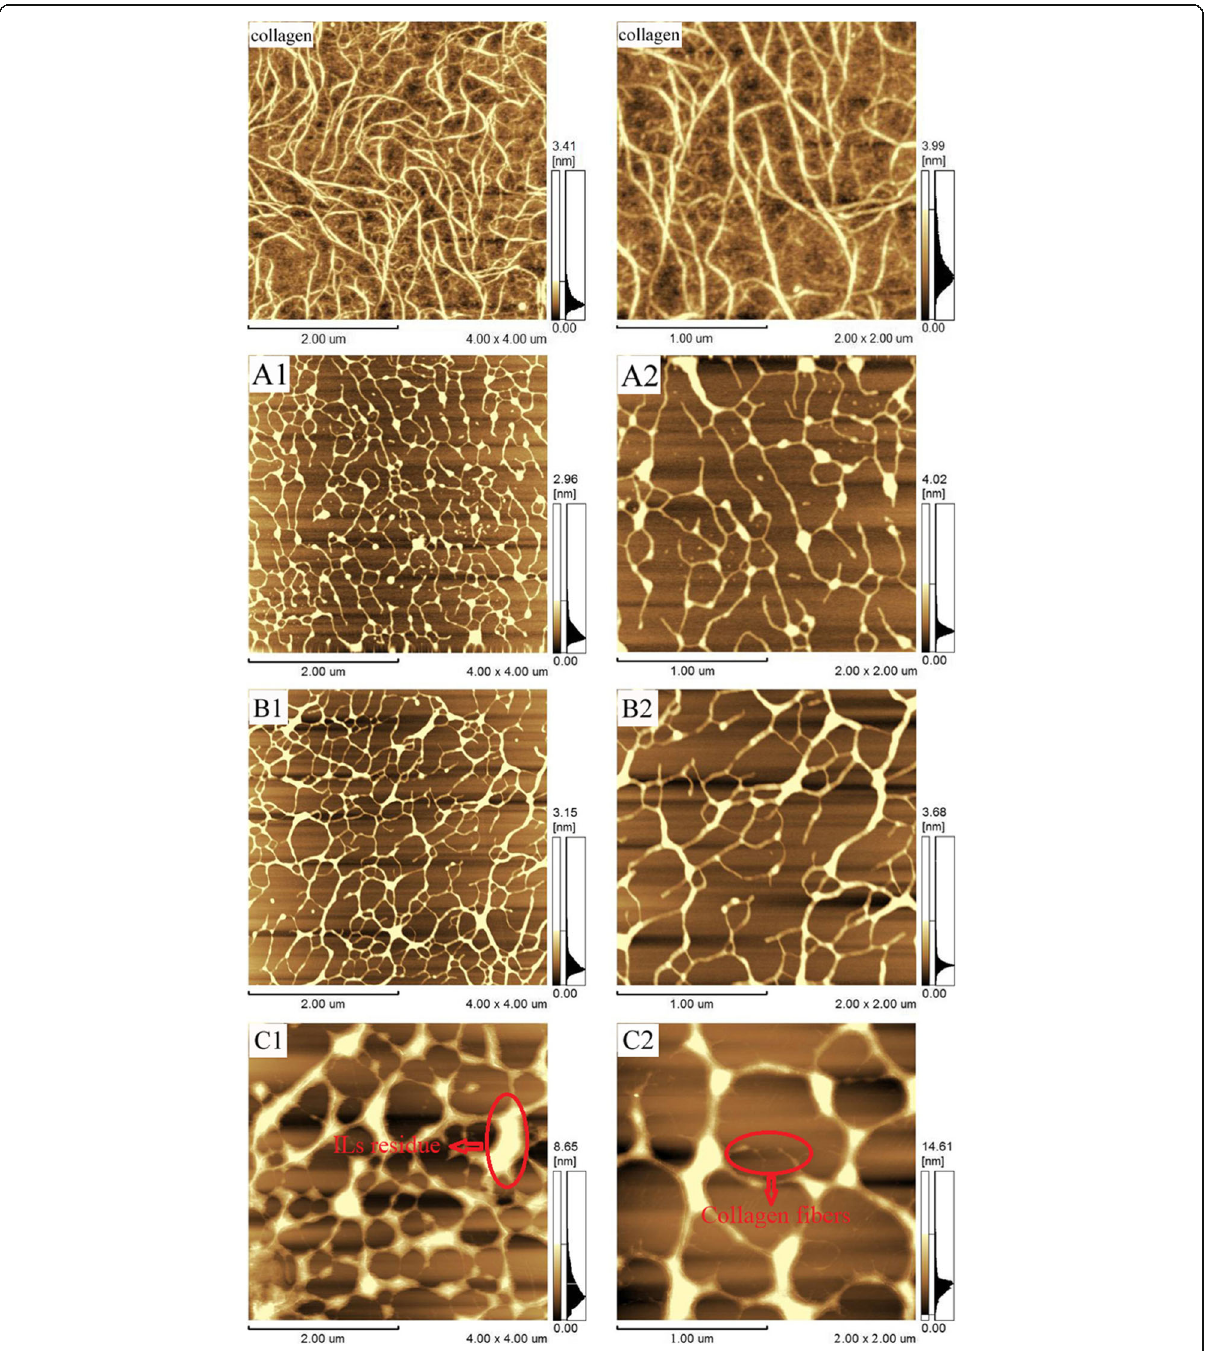
Fig. 9 AFM images of the native collagen and collagen samples dissolved in different concentrations of [EMIM][Ac]. Col/ILs-soluble10% ( A1 , A2 ), Col/ILs-soluble30% ( B1 , B2 ), Col/ILs-soluble50% ( C1 , C2 ), 4.00 × 4.00 μ m ( A1 , B1 , C1 ), 2.00 × 2.00 μ m ( A2 , B2 , C2